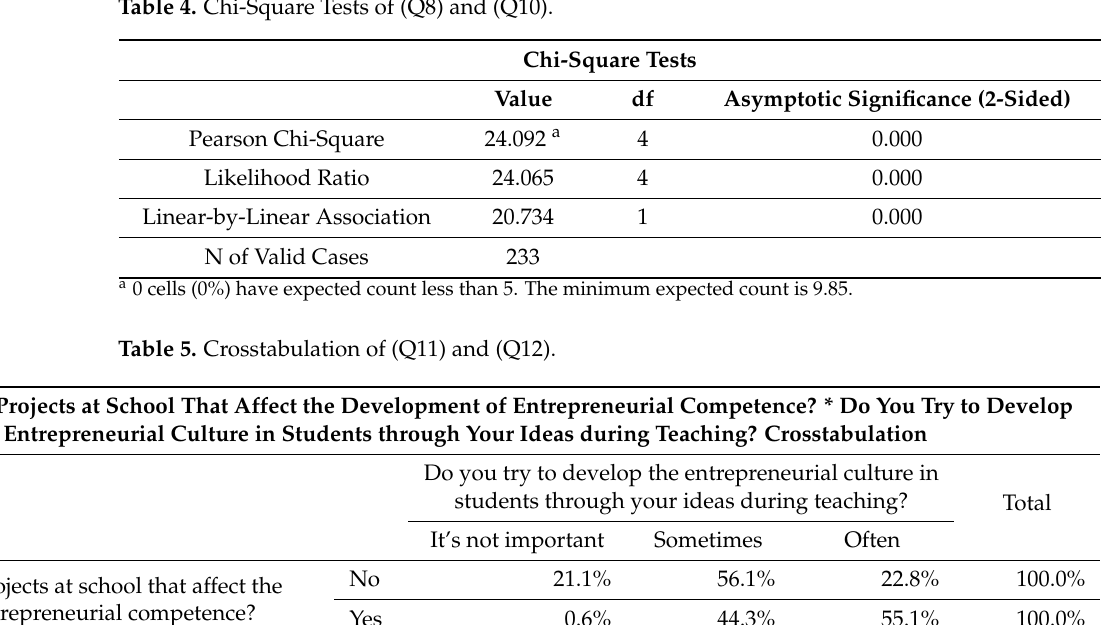
Table 4. Chi-Square Tests of (Q8) and (Q10).